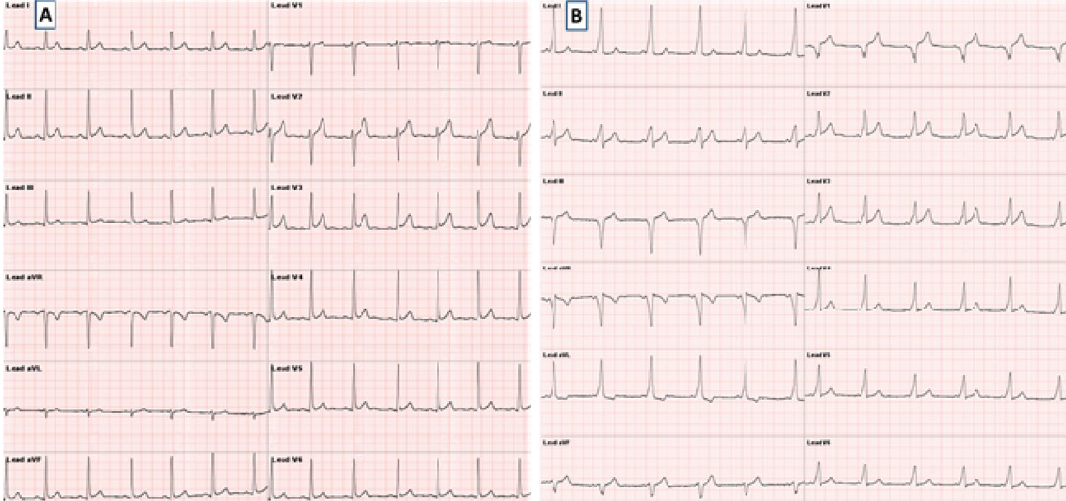
Fig. 1 A: 12-lead surface electrocardiogram at admission was normal in twin A without evidence of ventricular pre-excitation. B: 12-lead surface electrocardiogram at admission in twin B showed a right midseptal ventricular